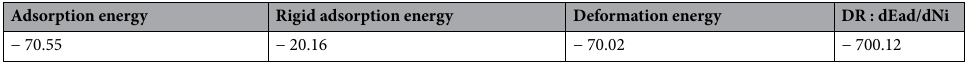
Table 4. Adsorption energy (kcal/mol), rigid adsorption energy, deformation energy, and substrate-adsorbate configurations (dE ads /d Ni ) for the adsorption configuration of MB dye on the AC/NZ nanocomposite surface.